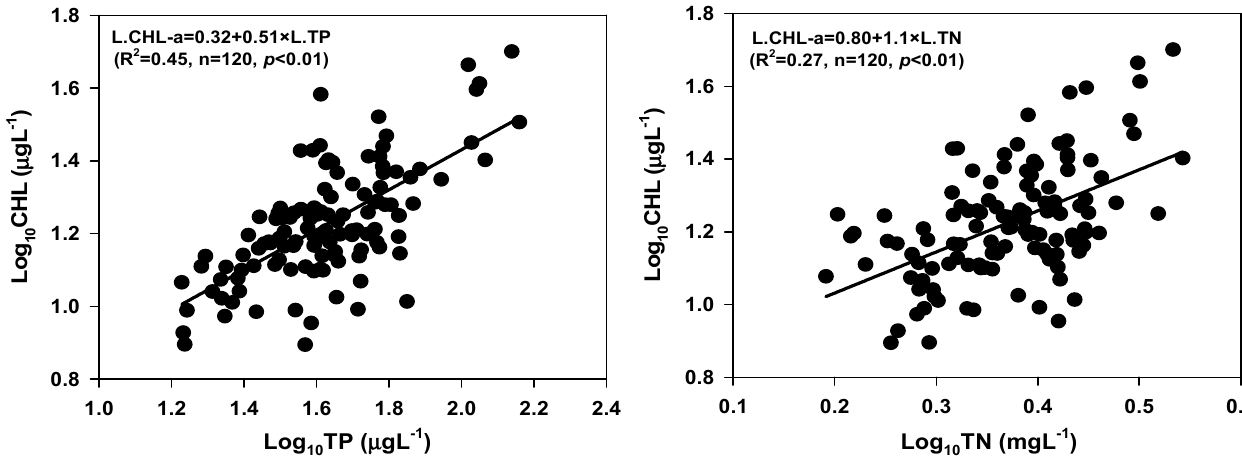
Figure 4. Empirical relationship of CHL-a, TP, and TN. TP—total phosphorus, TN—total nitrogen, CHL—chlorophyll-a.